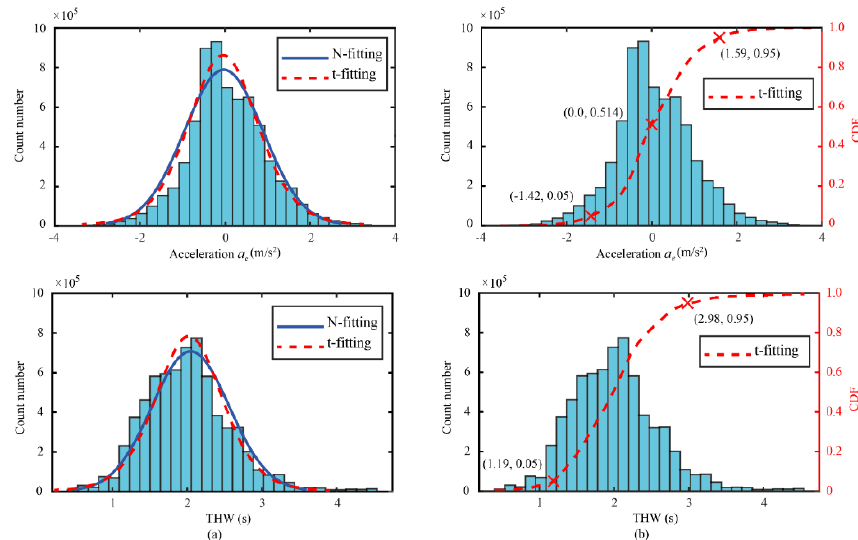
Figure 5. Histograms of the data collected from drivers and the fitting results of threshold values for two variables, ( a ) statistical results of driving data and fitting results of acceleration ( a e ) and THW, using normal and t distributions, ( b ) statistical results of driving data and the fitting results of the cumulative distribution function.